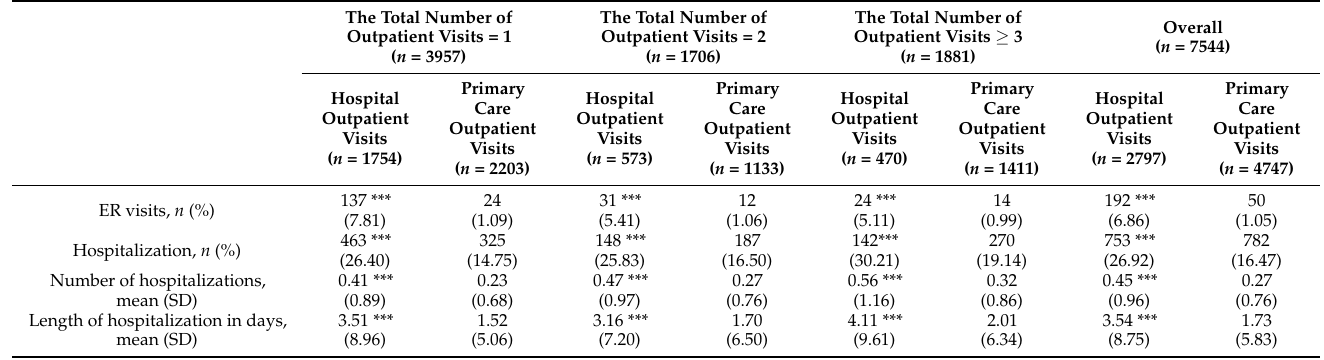
Table 3. ER and hospital inpatient services utilization by the outpatient visit types.